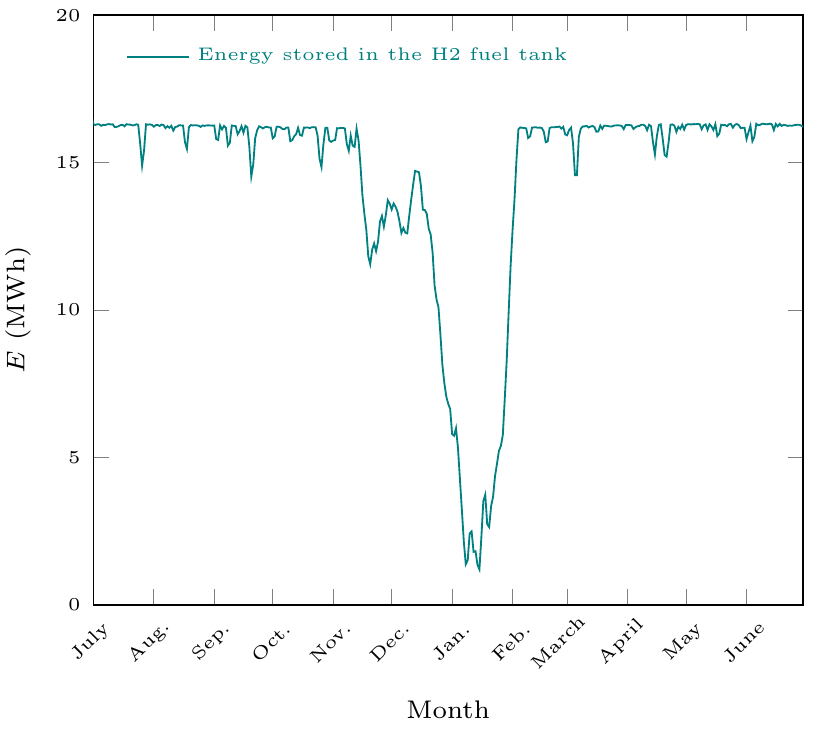
Figure 8. Storage evolution in the second case over one year, on a daily basis, from June to May. As in the first case, the increase of the energy prices and the omission of the transporta- tion cost are favorable to hydrogen. The negative values of H 2 cost for those two